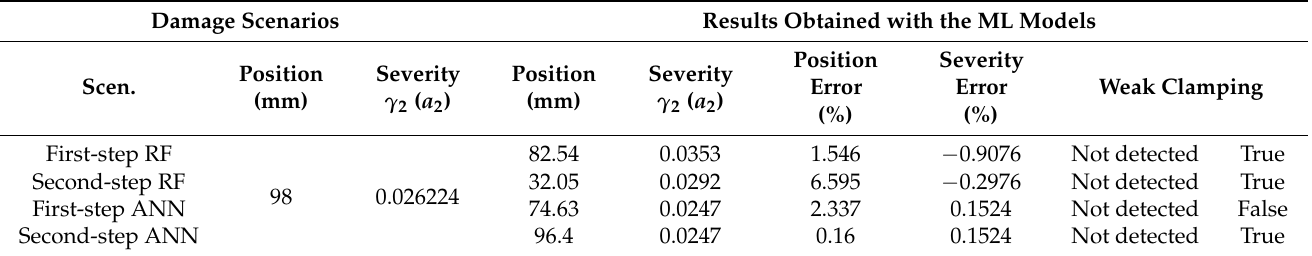
Table 19. Crack assessment for a damaged beam with non-ideal (but unchanged) clamping (case 1ii). Damage Scenarios Results Obtained with the ML